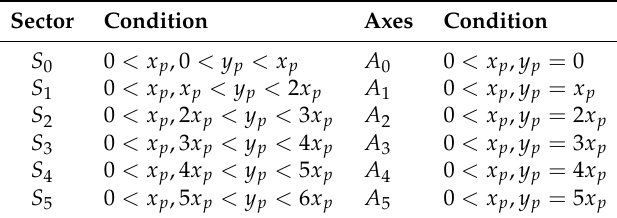
Figure 2. Hexagonal Coordinates (cid:104) x , y (cid:105) h , Polar Coordinates (cid:104) x , y (cid:105) p , Sectors S k and Axes A k for 0 ≤ k ≤ 5. Table 1. Definition of Sectors S k and Axes A k